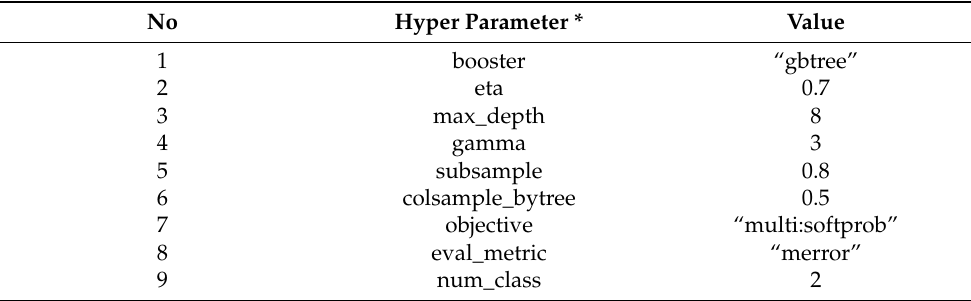
Table 4. Hyper parameters of proposed XGboost prediction